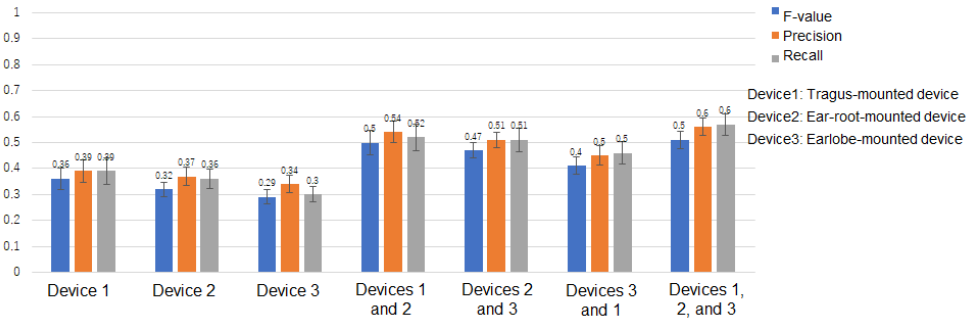
Figure 13. The results of Evaluation 3 testing with leave-one-user-out. The average F-value for each device